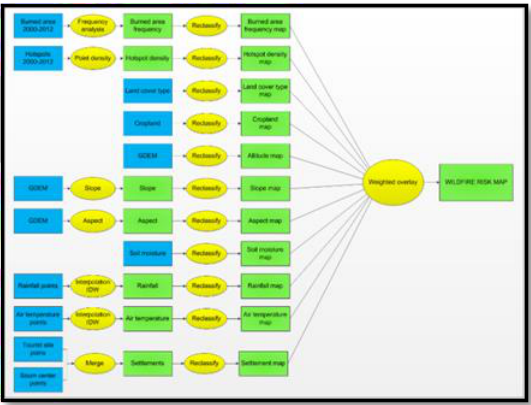
Figure 5. Wildfire risk map of MCA Modelling